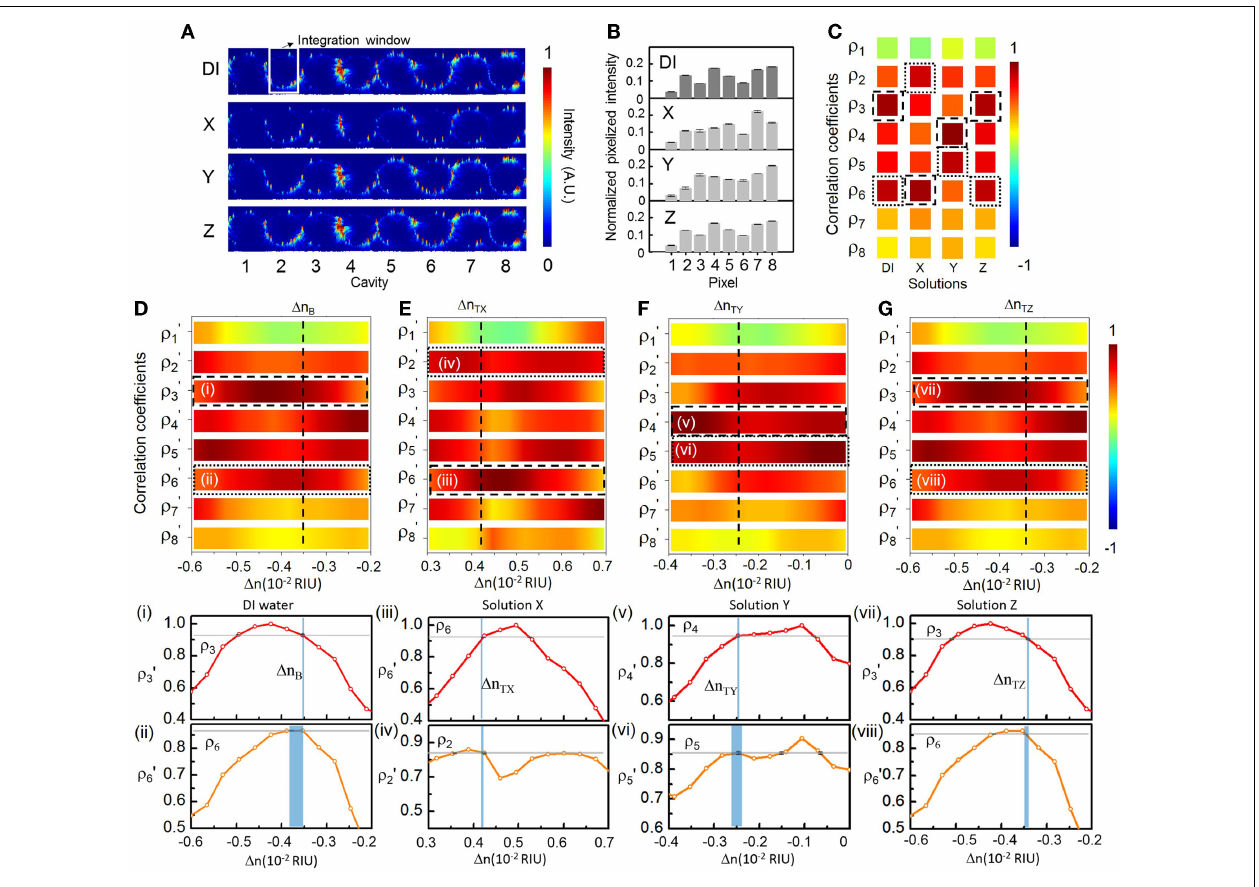
FIGURE 7 | (A) Measured elastic-light-scattering images of CROW upon the buffer solution and the three blind-test solutions X, Y, and Z at an arbitrarily set probe wavelength λ p1 . The white-line box indicates the integration window for pixelization. (B) Normalized pixelized patterns upon the buffer solution and solutions X, Y, and Z at λ p1 . (C) Calculated correlation coefficients upon the